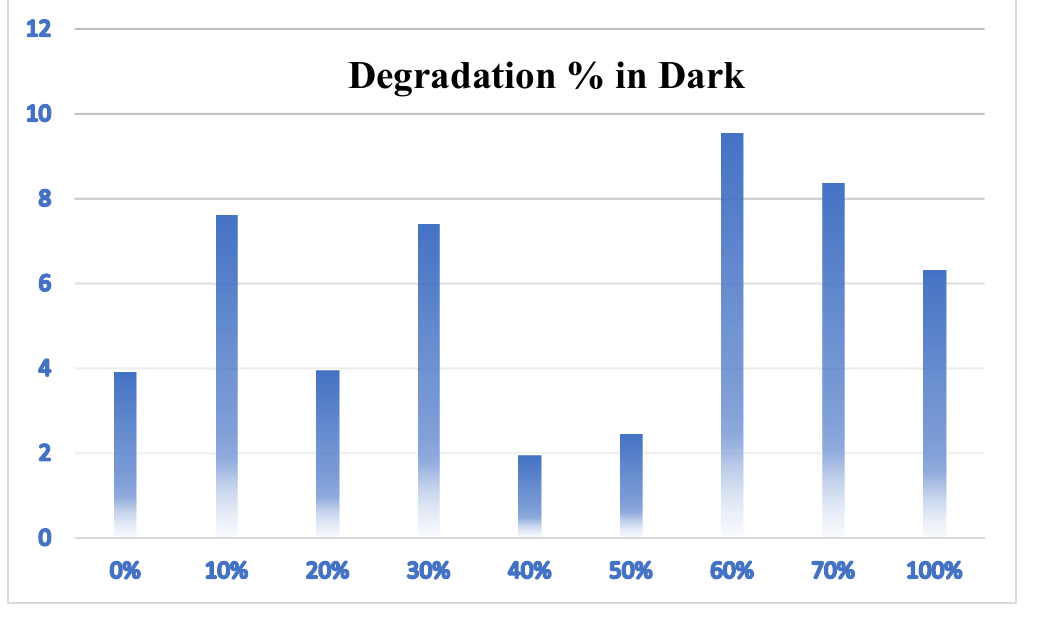
Figure 6. Photocatalytic degradation of CR under dark conditions.